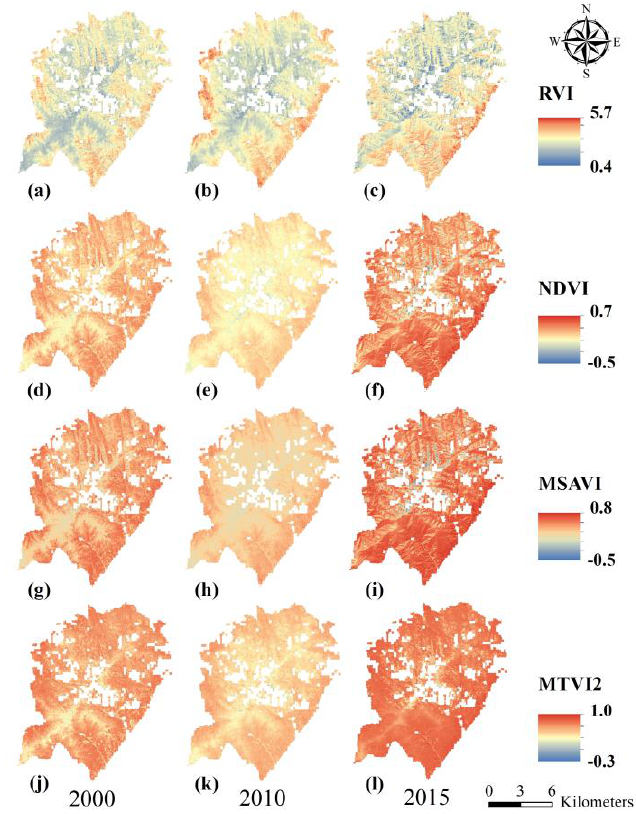
Figure A3. The vegetation indices in the Huangshan UNESCO Global Geopark: RVI in 2000 ( a ), 2010 ( b ) and 2015 ( c ); NDVI in 2000 ( d ), 2010 ( e ), and 2015 ( f ); MSAVI in 2000 ( g ), 2010 ( h ), and 2015 ( i ); and MTVI2 in 2000 ( j ), 2010 (k), and 2015 ( l ).